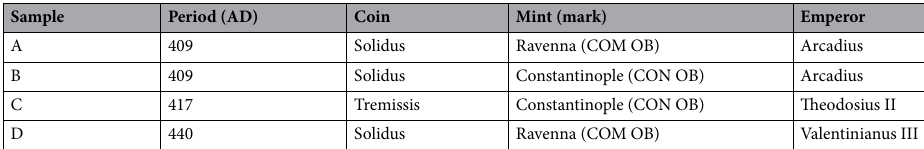
Table 5. Details of the four coins analysed in this work. The estimated year is the one marking the middle of the reign period of the emperor pictured on the obverse of the